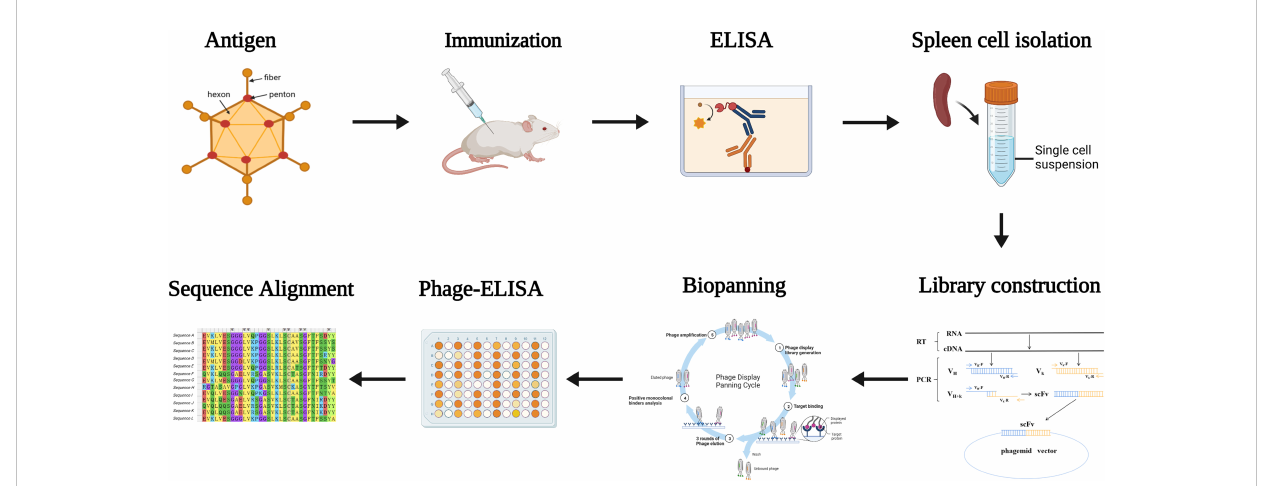
FIGURE 1 Diagram of the strategy for immunization and screening used to isolate mAbs recognizing HAdV55. Mice were immunized with inactivated and puri fi ed HAdV55 virus, and serum was collected to determine antibody titer. Following that, RNA from mouse spleen was isolated and reverse- transcribed into cDNA. The light and heavy chain variable region genes (VL and VH) of the antibodies were ampli fi ed using cDNA as a template. The gene fragment encoding the single-chain fragment variable (scFv) antibody was obtained by amplifying VL and VH using overlapping extension PCR, and scFv was then cloned into the phage vector to create the scFv phage display library. After that, the scFv phage display library was screened three times with puri fi ed HAdV55 as the target. Using Phage-ELISA, positive phage clones were identi fi ed. The screened positive phage clones were subjected to a sequence